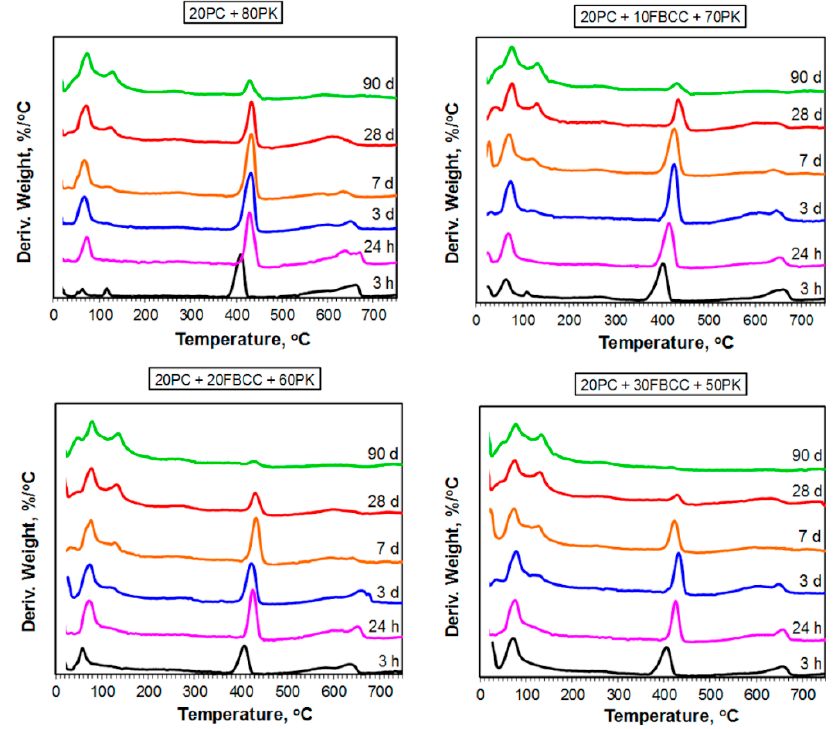
Figure 5. DTG curves for blended four-component binders after different times of hydration.